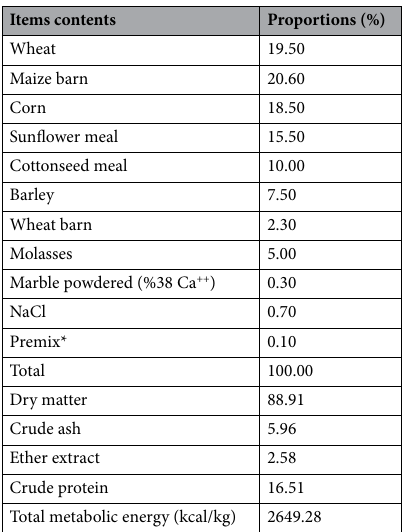
Table 3. Chemical and physical composition of concentrate feeds; * : Per 1.5 kg premix contains 15 000 000 IU Vit A, 3 000 000 IU Vit D3, 50 000 IU Vit E, 50 g manganese, 50 g ferrous, 50 g zinc, 10 g copper, 0.8 g iodine, 0.2 g cobalt, 0.3 g